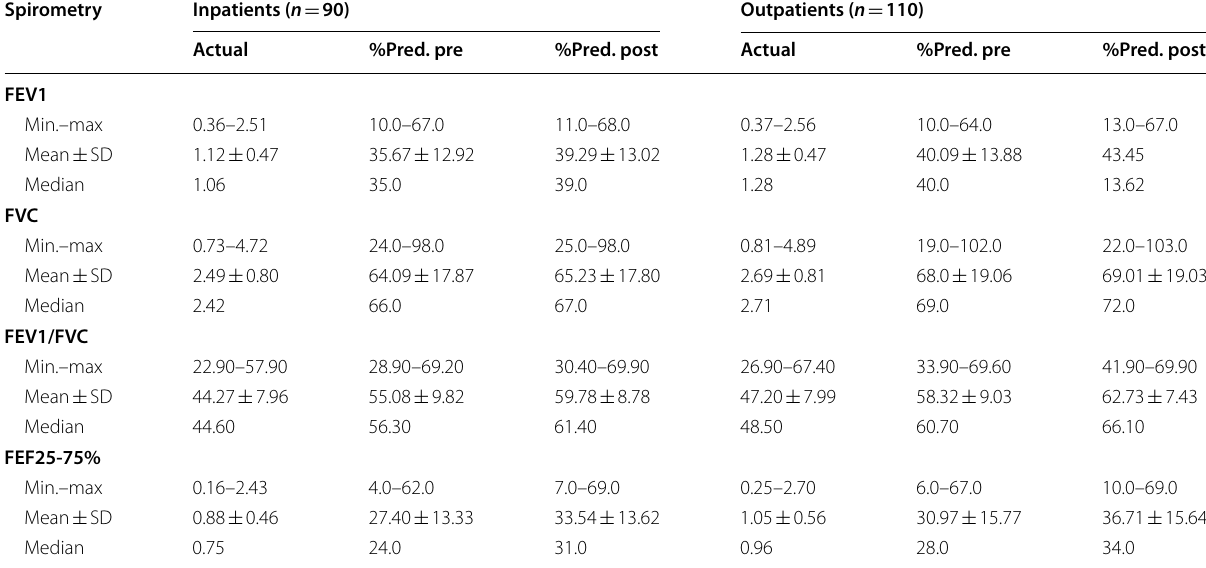
Table 3 Descriptive analysis of the two studied groups according to spirometry Spirometry